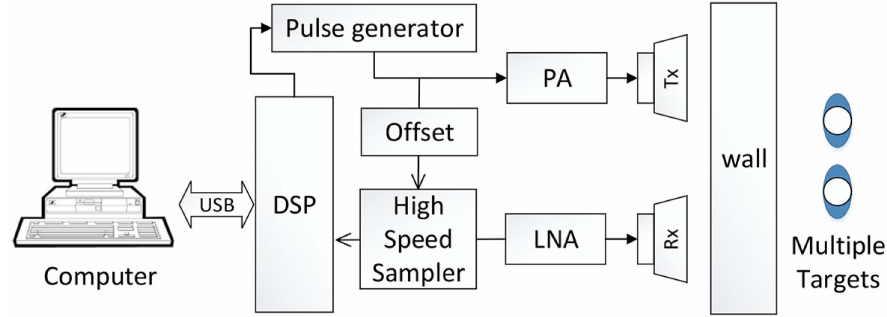
Figure 3. Block diagram to test multiple targets’ detection [68]. PA, power amplifier.